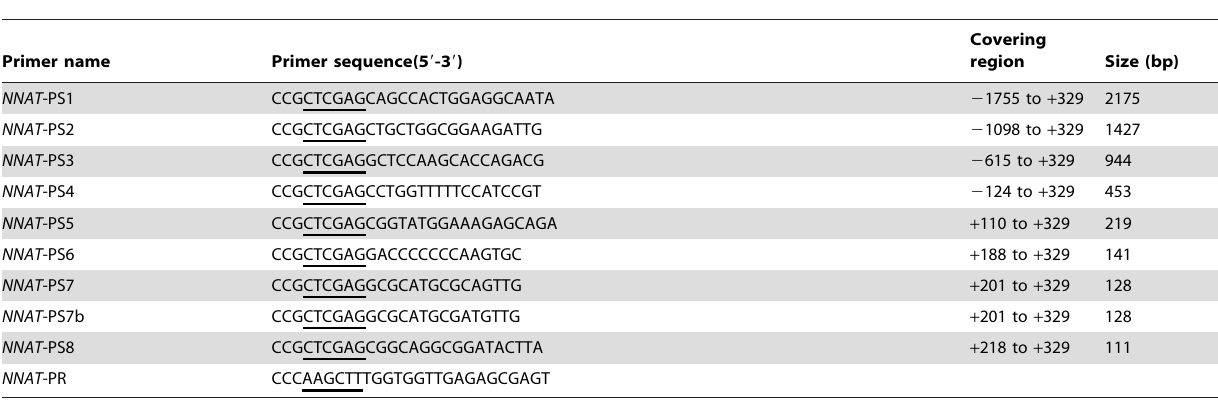
Table 3. Primers used in NNAT promoter serious deletion